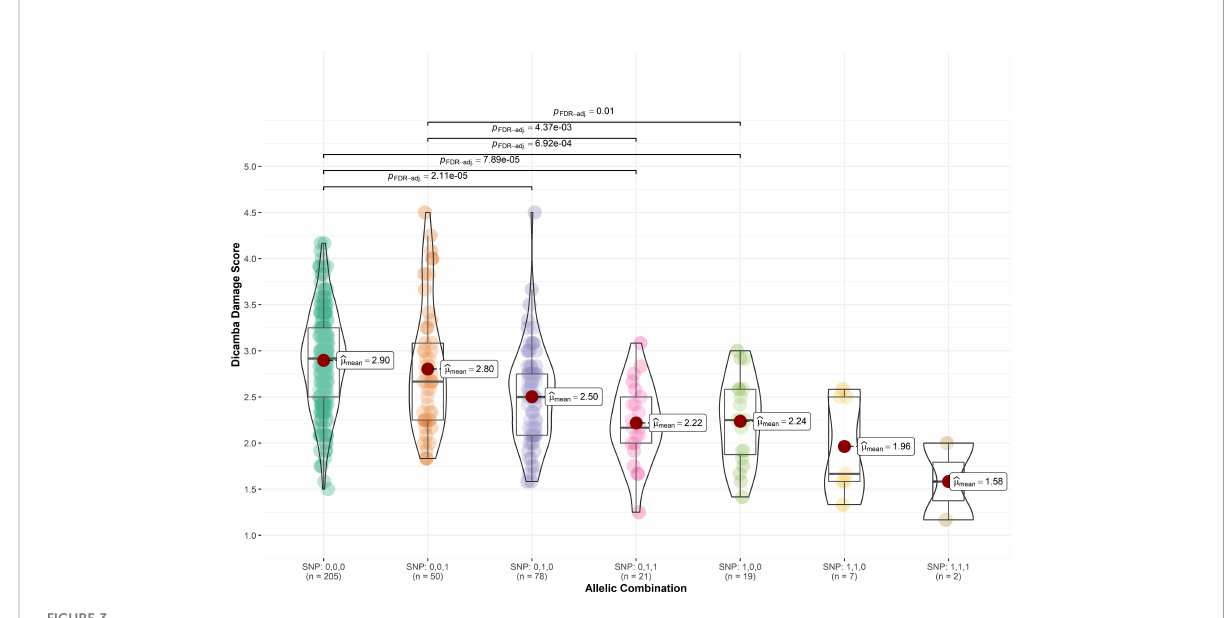
FIGURE 3 Distribution of off-target dicamba damage scores based on the allelic combination of SNPs ss715605561 (Chr. 10), ss715635349 (Chr. 19), and ss715632413 (Chr. 18). Favorable alleles were represented as 1 whereas unfavorable alleles were represented as 0.